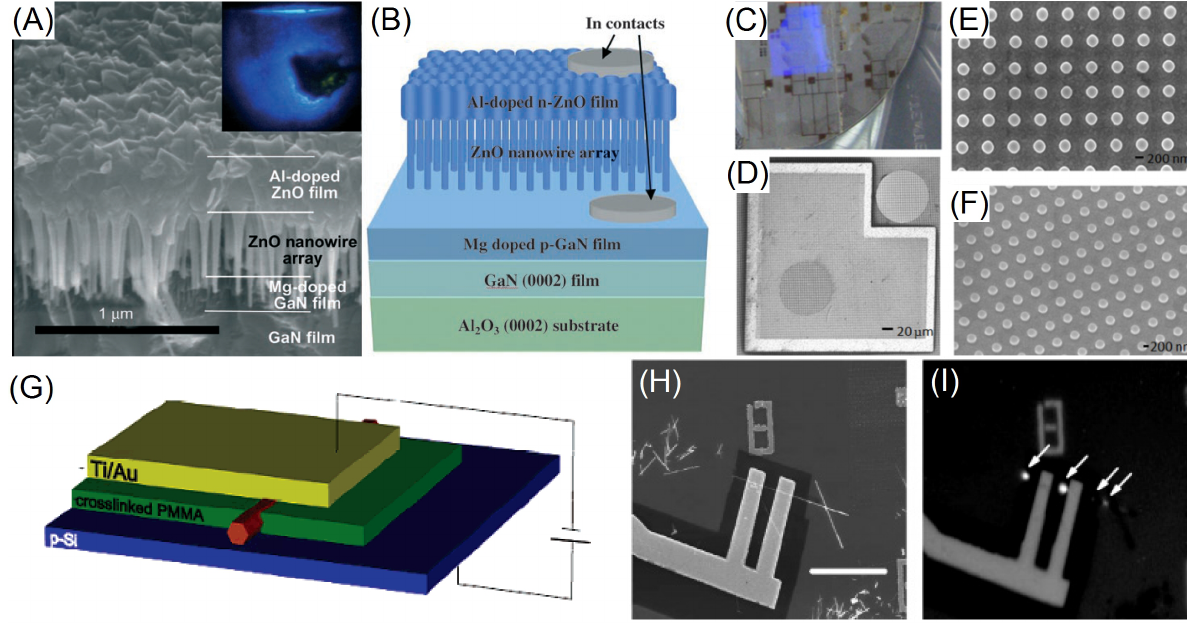
Figure 14: (A,B) SEM image and schematic of the Mg-doped GaN film/ZnO nanowire array/Al-doped ZnO film structures for nanometer-sized ZnO/GaN heterojunction applications. Inset: Photograph of blue-light emission from the heterojunction diodes observed through a micro- scope at the forward current. (C) Optical image of the ZnO-nanorod arrays imprinted on the GaN. (D) Top view micrograph image of the ZnO- nanorod arrays, along with their enlarged (E) top view and (F) tilt view SEM images. (G–I) Schematic description, SEM and optical images of a single ZnO nanowire/Si heterostructure. Reproduced with permission from Ref. [142] (A, B), [144] (E–F), and [ ? ] (G–I). SEM: secondary electron